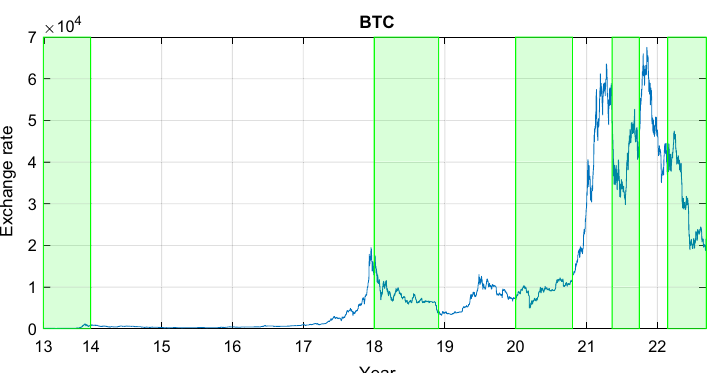
Fig. 1 Bitcoin exchange rate quoted against the USD. The shaded areas correspond to the main Bitcoin crashes documented in the financial literature, mainly, the 2013 meltdown, the 2018 selloff, the COVID-19 pandemic, the 2021 crash, and the Russia-Ukraine conflict in